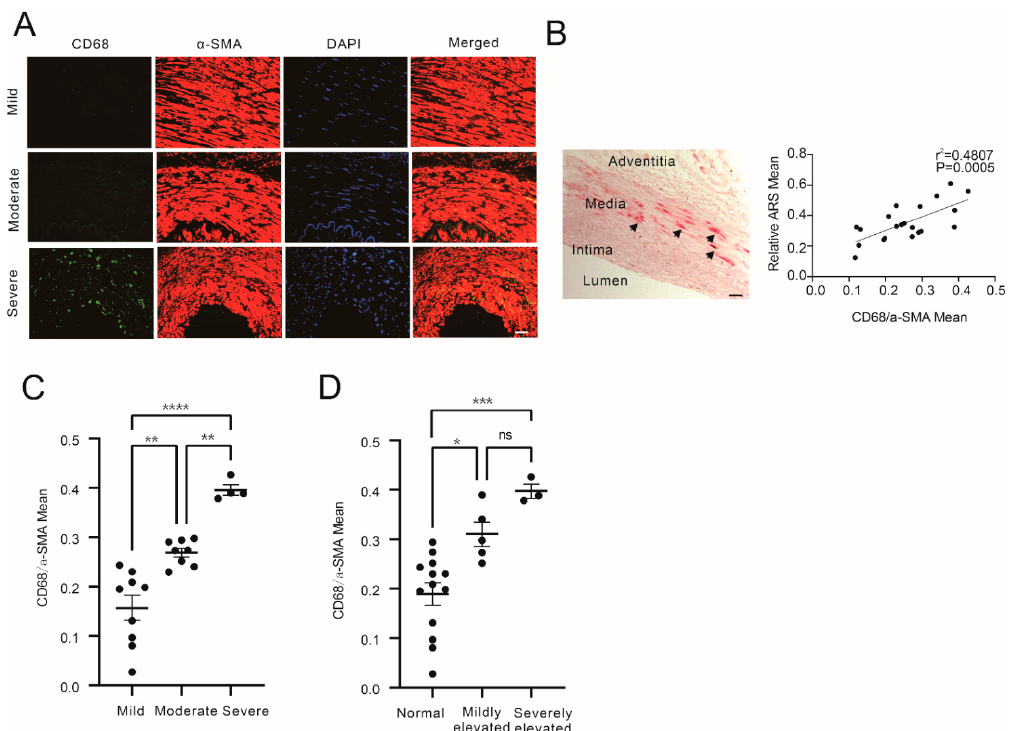
Figure 1. Macrophage infiltration increased in the media of CKD patients with aggravated calcifi- cation and increased blood phosphate. ( A ) Representative IF staining of CD68 and α -SMA of arteries of mildly, moderately, and severely calcified CKD patients. ( B ) Left, representative ARS staining of artery of patients (arrows show positive ARS staining); right, correlation of fluorescence intensity mean of CD68 normalized to α -SMA positive area (CD68/ α -SMA) and mean area of positive ARS Staining in arteries from CKD patients. ( C ) Comparison of relative CD68 fluorescence intensity in the media between CKD patients with different degrees of artery calcification (one-way ANOVA, n > 3). ( D ) Comparison of relative CD68 fluorescence intensity in the media between CKD patients with different blood phosphate levels (normal, mildly elevated, severely elevated) (one-way ANOVA, n > 3). * p < 0.05, ** p < 0.01, *** p < 0.001, **** p < 0.0001, n.s. not significant. Scale bar, 40 μ M.